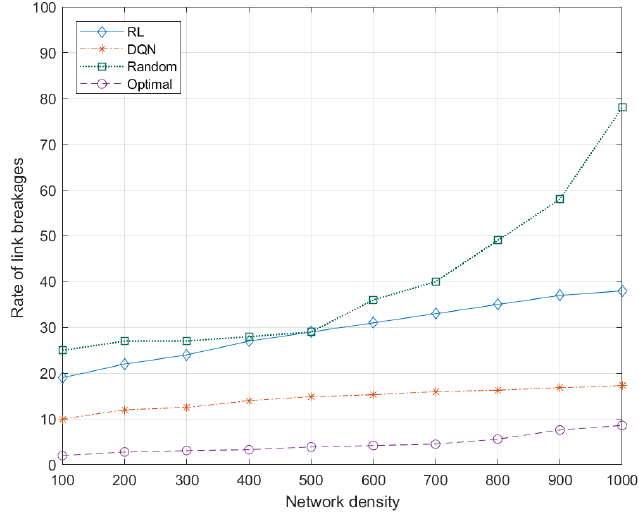
Figure 10. Rate of link breakages increases with respect to network density. DQN achieves lower values as compared to RL and random approaches. Lower rate of link breakages improves QoS and network lifetime.